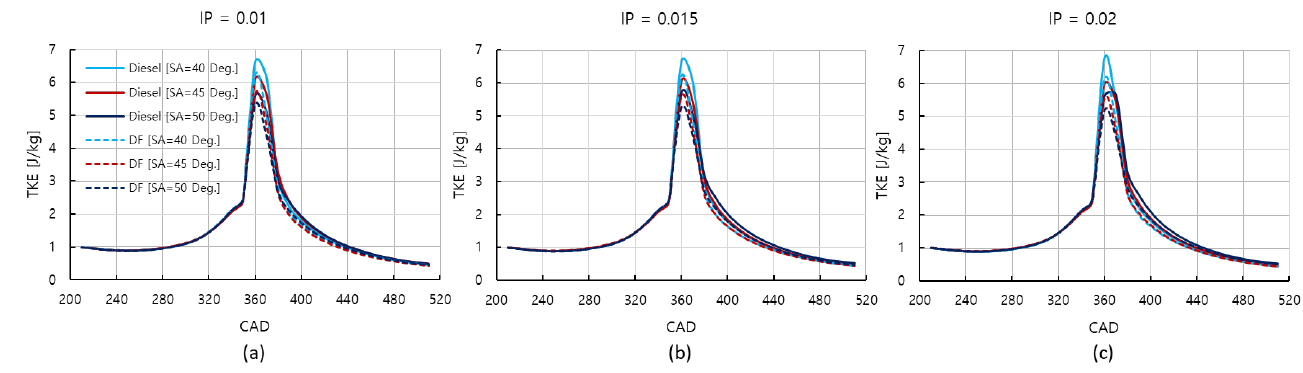
Figure 8. TKEs in the engine cylinder in all simulation cases: ( a ) IP = 0.001 m; ( b ) IP = 0.015 m; ( c ) IP = 0.02 m.